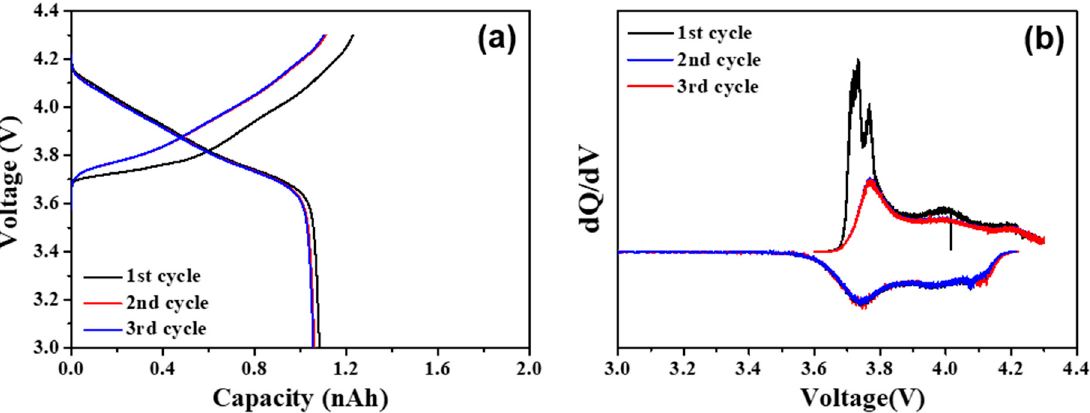
Figure 3. ( a ) Initial three cycles of NCM622-Li 6 PS 5 Cl system at 0.2 C current density and ( b ) differential analysis of initial cycles of NCM622-Li 6 PS 5 Cl system at 0.2 C.